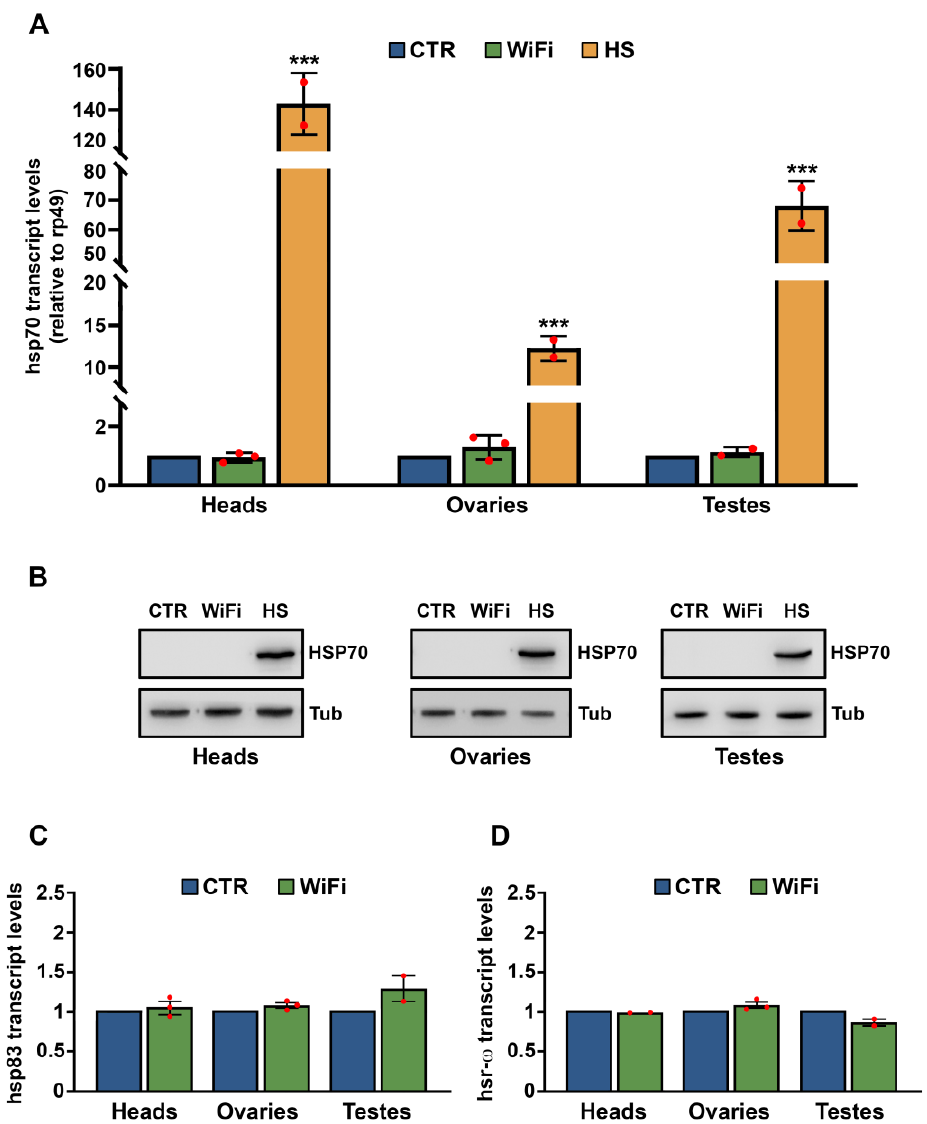
Figure 2. qRT-PCR ( A ) and western blot analysis ( B ) of Hsp70 gene expression in adult heads, ovaries and testes from control, WiFi-exposed and heat shocked (HS) flies. ( A ) Transcript levels were normalized to rp49 and displayed as fold change relative to the controls. The bar graph represents the mean ± SEM from at least two independent experiments. Red dots indicate individual data points ( *** p ≤ 0.001; Unpaired t test). ( B ) HSP70 protein levels were normalized to α -Tubulin. qRT-PCR analysis of Hsp83 ( C ) and hsr- ω ( D ) transcripts in adult heads, ovaries, and testes from control and WiFi-exposed flies. Transcript levels were normalized to rp49 and displayed as fold change relative to the controls. Bar graph represents the mean ± SEM from at least two independent experiments. Red dots indicate individual data